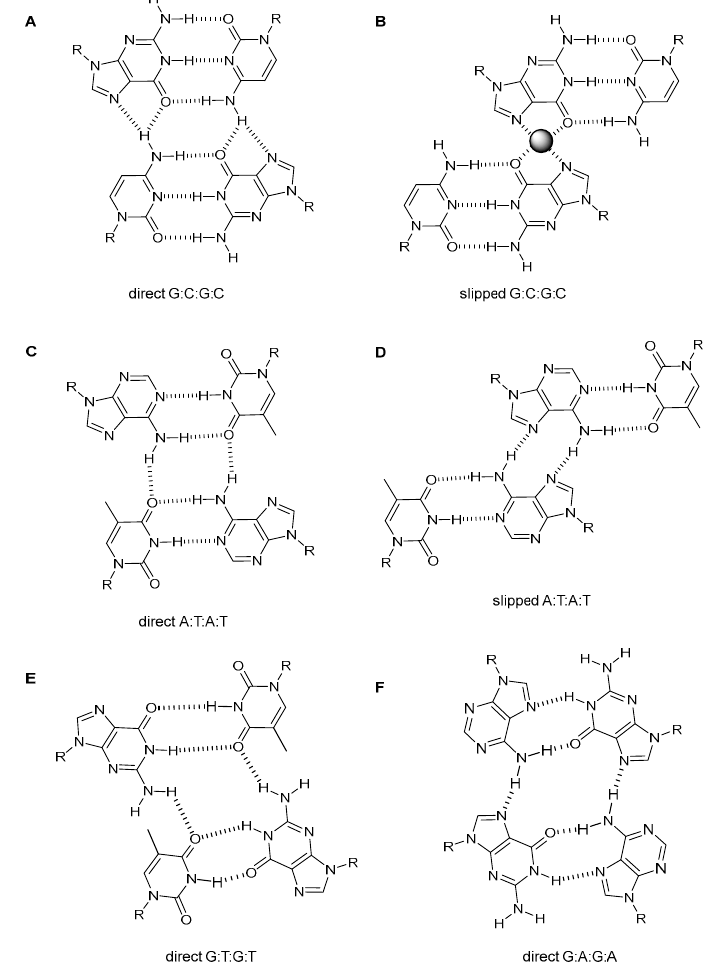
Figure 3. Schemes of the different major groove tetrads discussed in the text. ( A ) Direct major groove